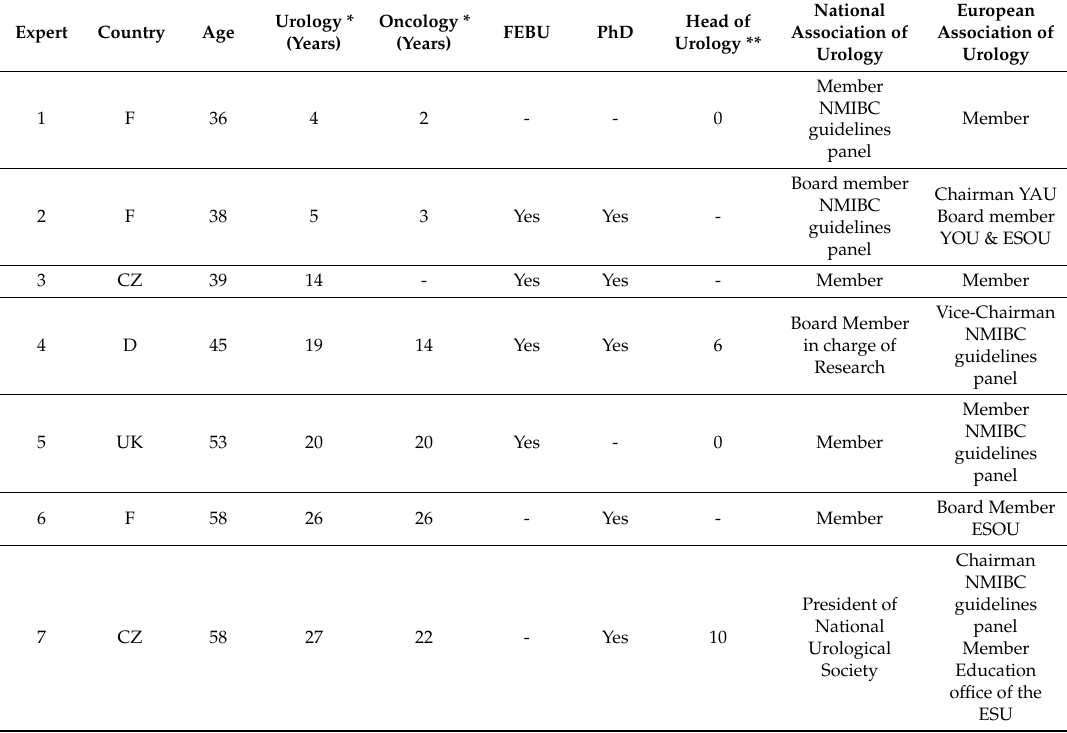
Table 4. Panel participants’ characteristics and experience in